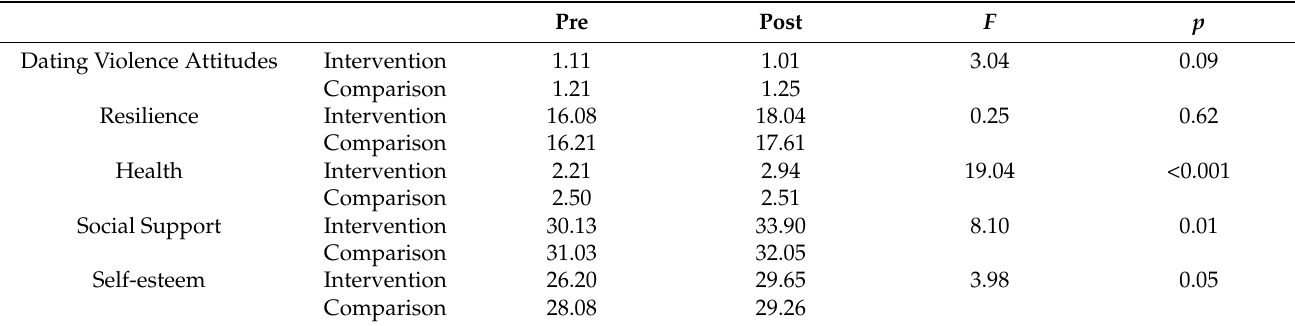
Table 2. Descriptive Statistics by Condition and ANOVA